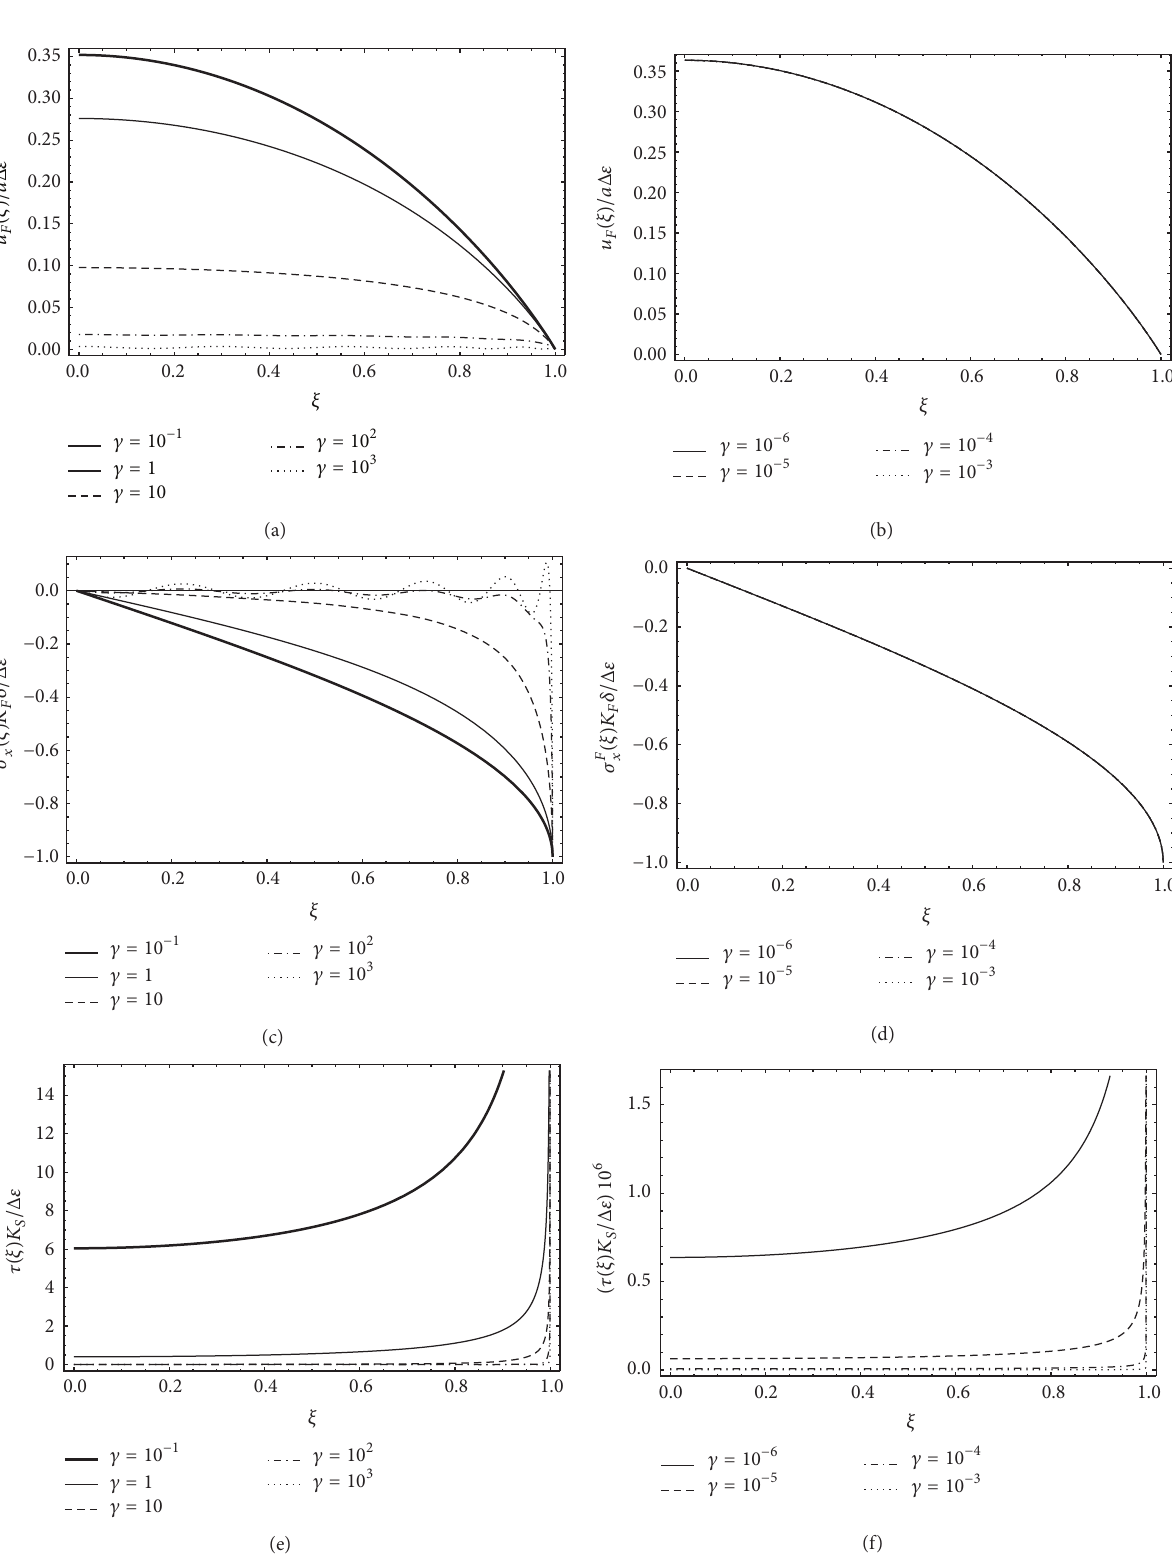
Figure 8: Longitudinal displacement, longitudinal stress, and shear stress field of skew-symmetric loading case condition for high (left (a), (c), and (e)) and low (right (b), (d), and (f)) values of 𝛾 ,